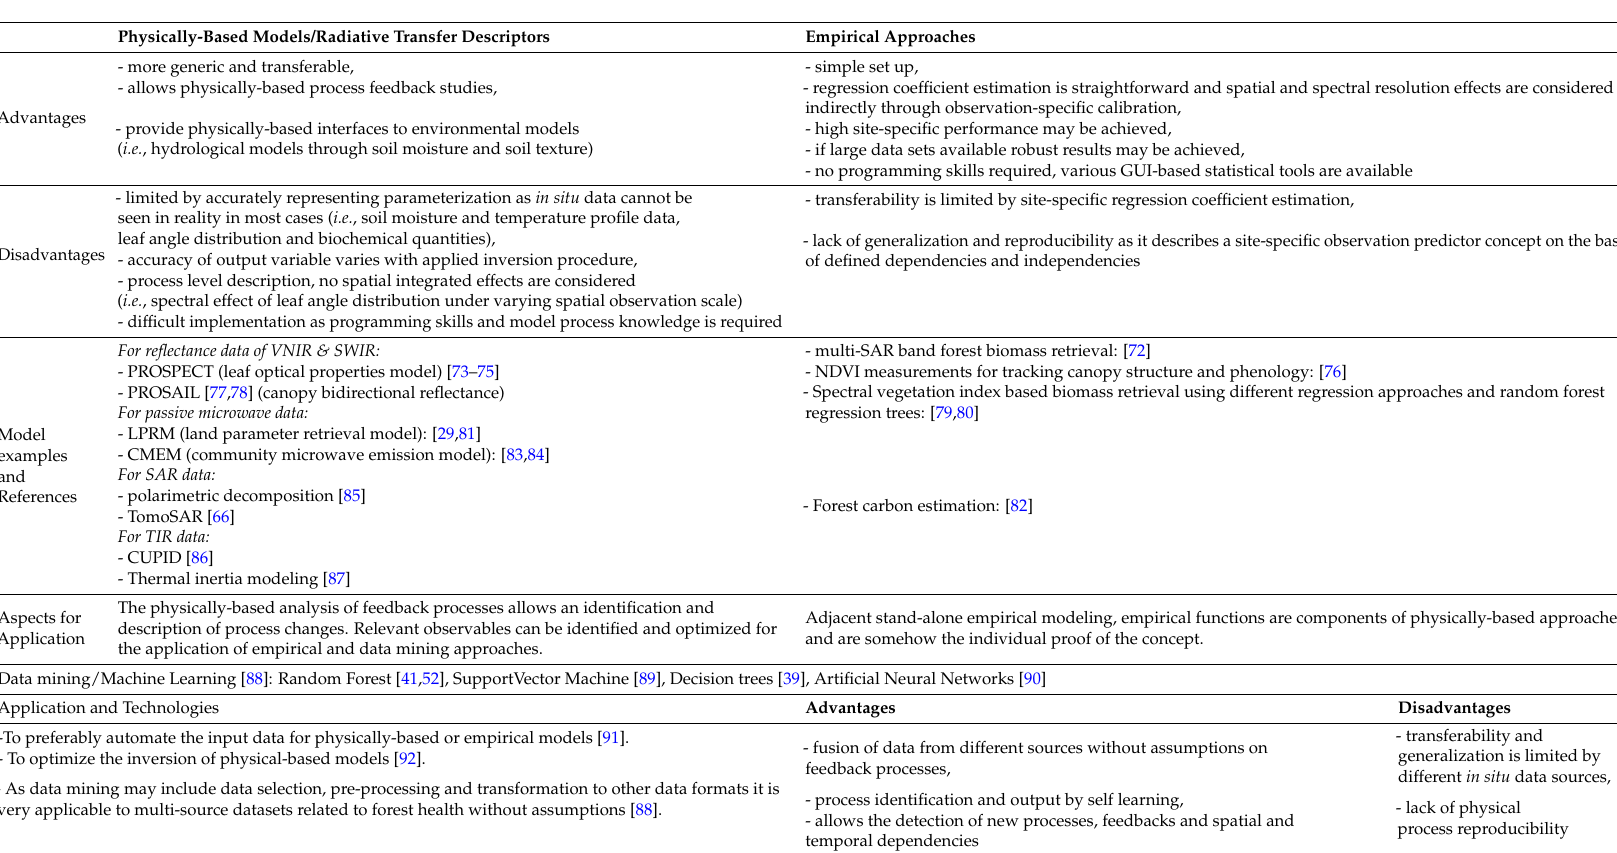
Table 4. Summary of the key advantages and disadvantages of methods for retrieving quantitative forest variables from remote sensing observations. Physically-Based Models/Radiative Transfer